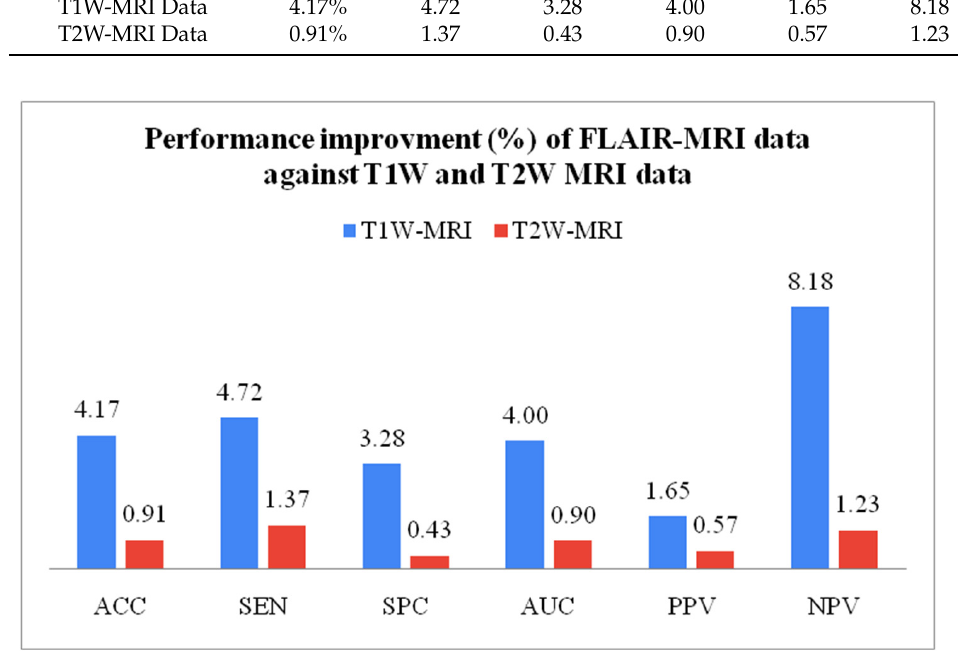
Figure 13. Highest performances of three MRI sequence datasets.